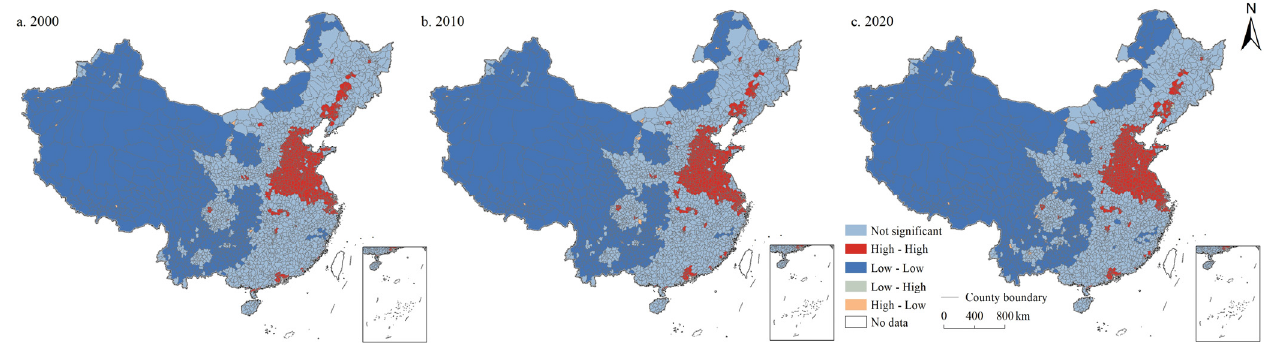
Figure 13. Spatial autocorrelation of coordination degree of production-living-ecological space in China during 2000–2020.